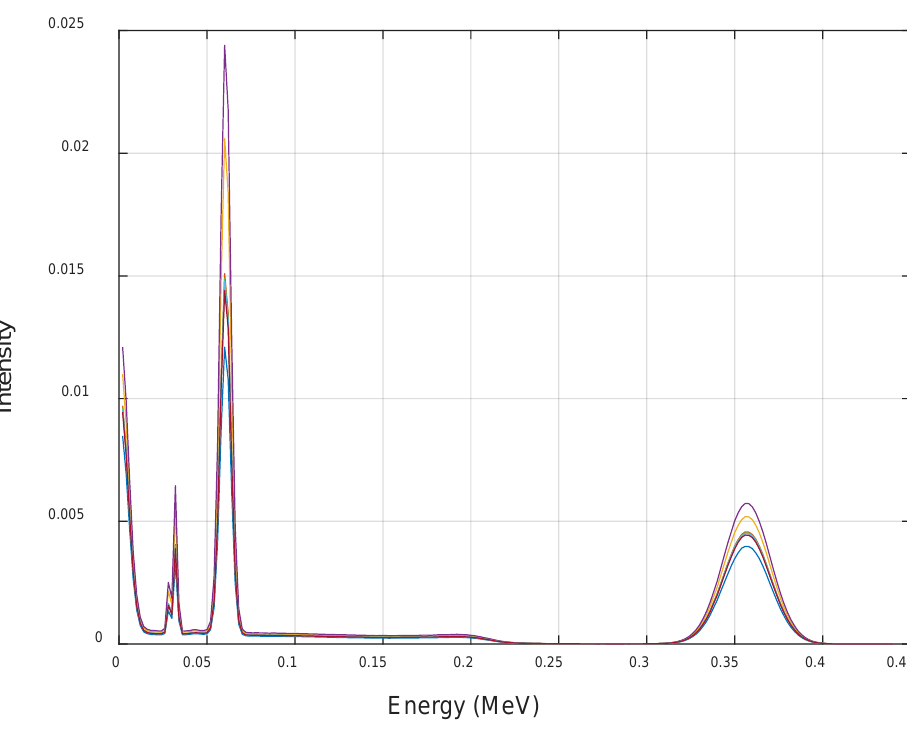
Figure 2. Recorded spectrum by the detector.